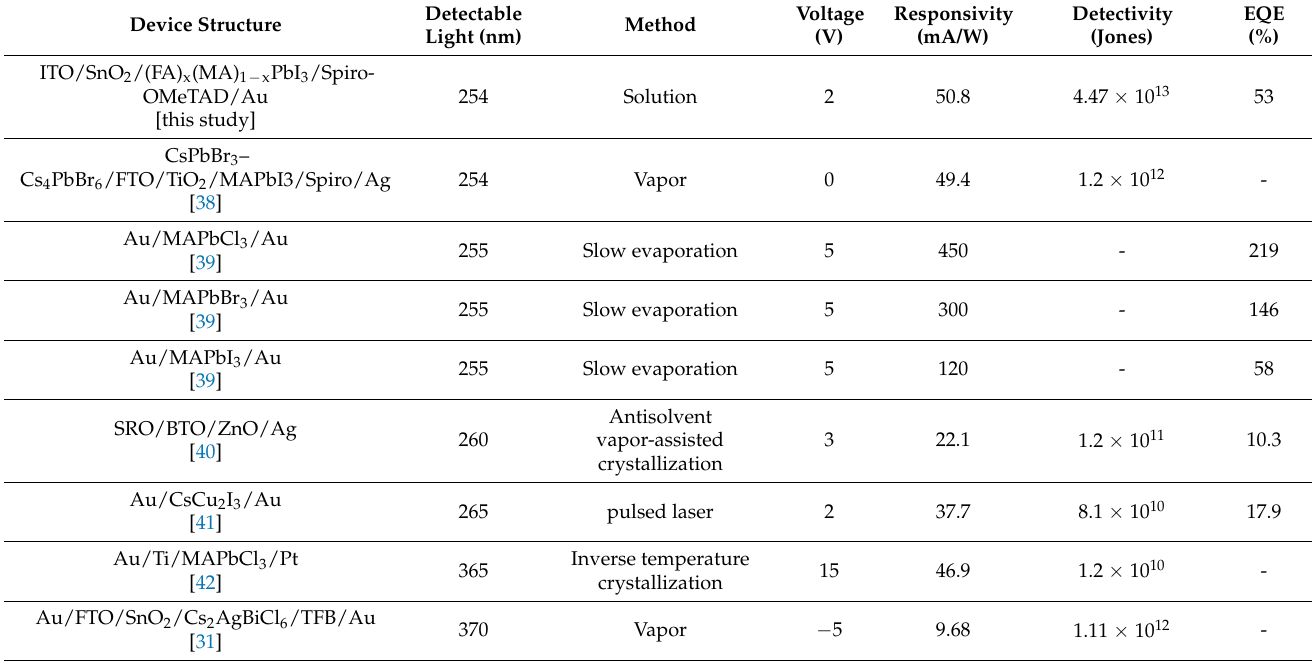
Table 2. Comparison of important parameters of various recently studied UV